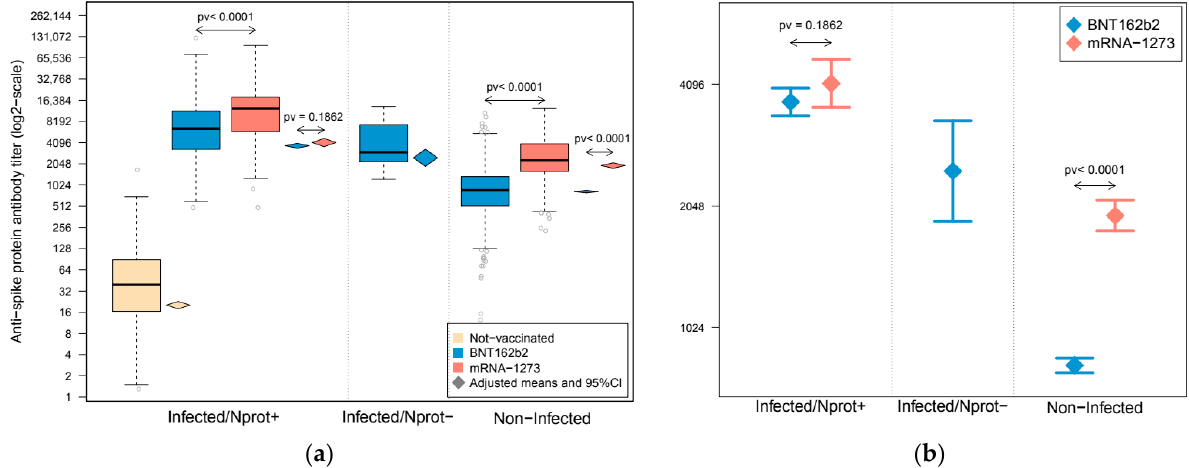
Figure 1. Antibody response against SARS-CoV-2 spike protein in a cohort of healthcare workers (HCWs). Subjects were grouped according to their infection and conservation status of antibody response against the nucleocapsid protein. Boxplots represent the distribution of anti-spike protein antibody quantification. ( a ) Upper and lower bounds of boxes indicate the 75th and 25th percentiles, respectively. Whiskers extend 1.5 times the interquartile range (IQR) from each extreme of the box. Diamond-shape symbols represent the adjusted group means of anti-spike protein antibody titer after statistical control for confounders, and their extension represents their 95% confidence intervals. ( b ) Adjusted means and 95% confidence intervals of the anti-spike protein antibody titer after statistical control for confounders in the vaccinated subject groups. Estimations were derived from a linear mixed-effect model in which the sample’s donor was modeled as a random effect to account for intra-individual variability, and were adjusted by sex, age, BMI, arterial hypertension, smoking habit and time interval from infection and/or vaccination to serology. Anti-spike protein antibody quantifications are expressed in a